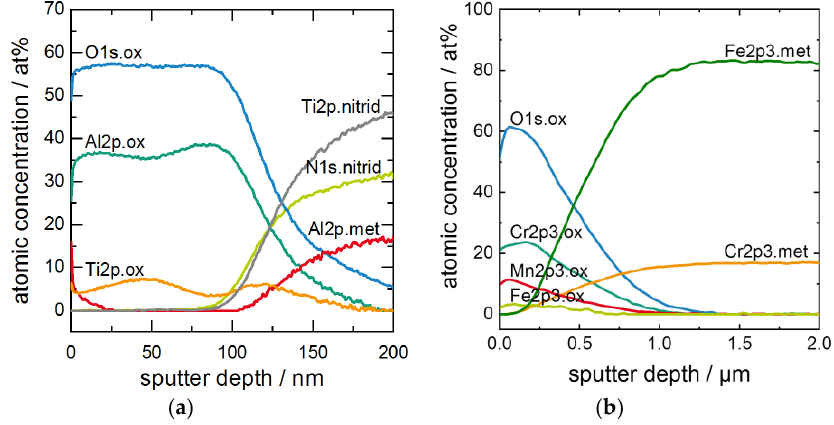
Figure 4. XPS depth profiles after oxidation for 100 h at 700°C of (a) Ti 2 AlN coating, and (b) uncoated ferritic steel substrate.